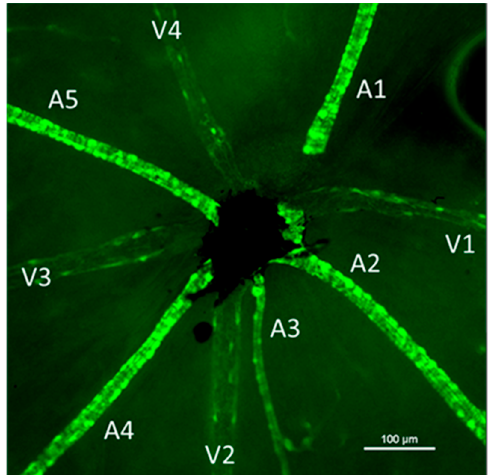
Figure 5. Representative image of the central retina showing the vascular branches identified by their smooth muscle actin staining. Each arteriole is labeled (A) and venules are identified with a (V). Arterioles had a brighter, more banded and continuous staining while venules had punctate cells on their surface. Images were captured using fluorescence microscopy. Scale bar represents 100 µm .